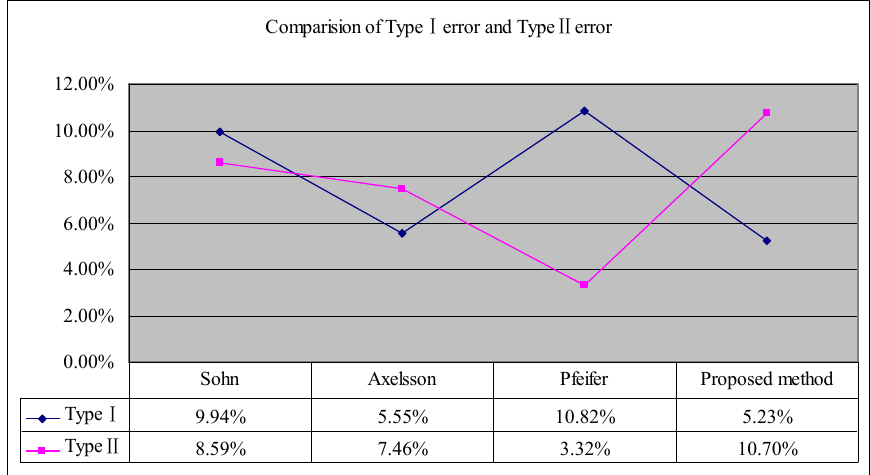
Figure 7. Comparison of average type I error and average type II error of the four filtering algorithms.